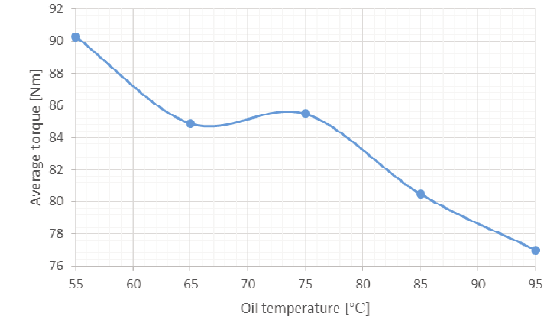
Fig. 15. Averaged torque curve as a function of oil temperature